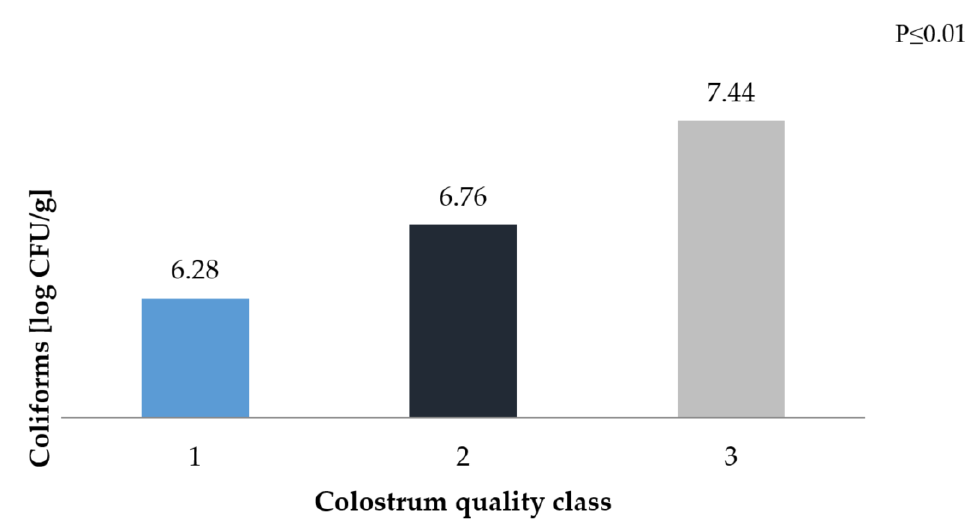
Figure 4. Coliforms count in faecal samples depending on the class of colostrum.